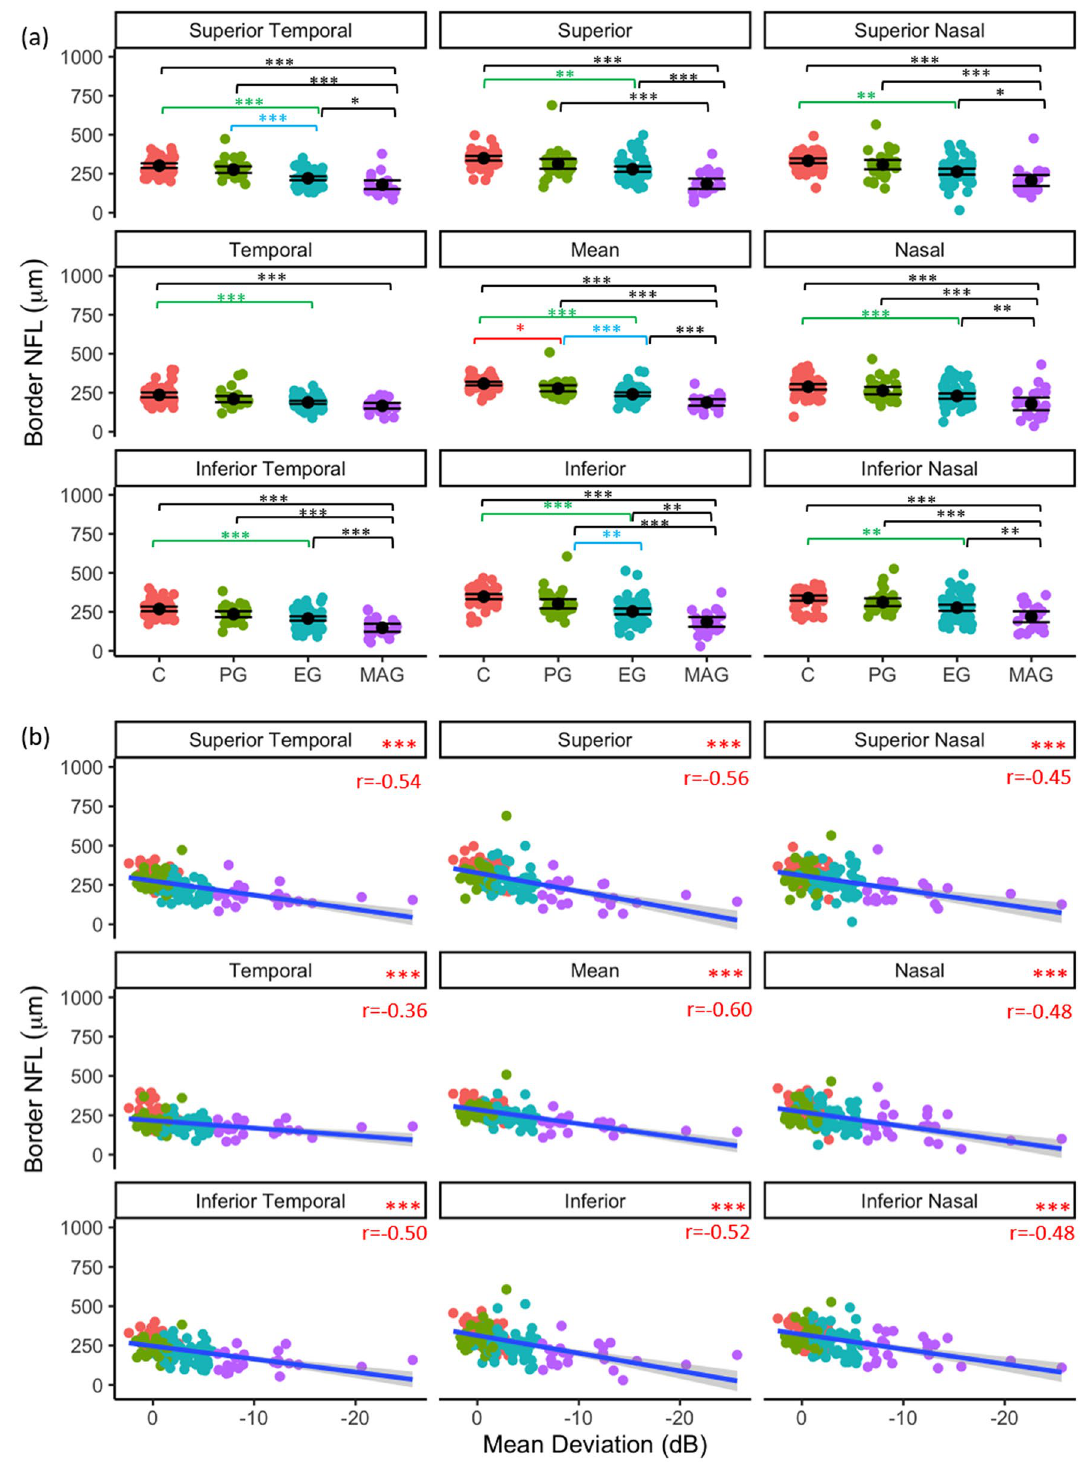
Figure 2. Regional border NFL as a function of glaucoma disease stage ( a ); black point represents mean and error bars indicate 95% confidence intervals, and ( b ) visual field status (VF MD). Blue line represents regression line and grey shading indicates 95% confidence intervals. Red text indicates significant Pearson’s correlation (r) values at p < 0.05. * p < 0.05, ** p < 0.01, *** p <